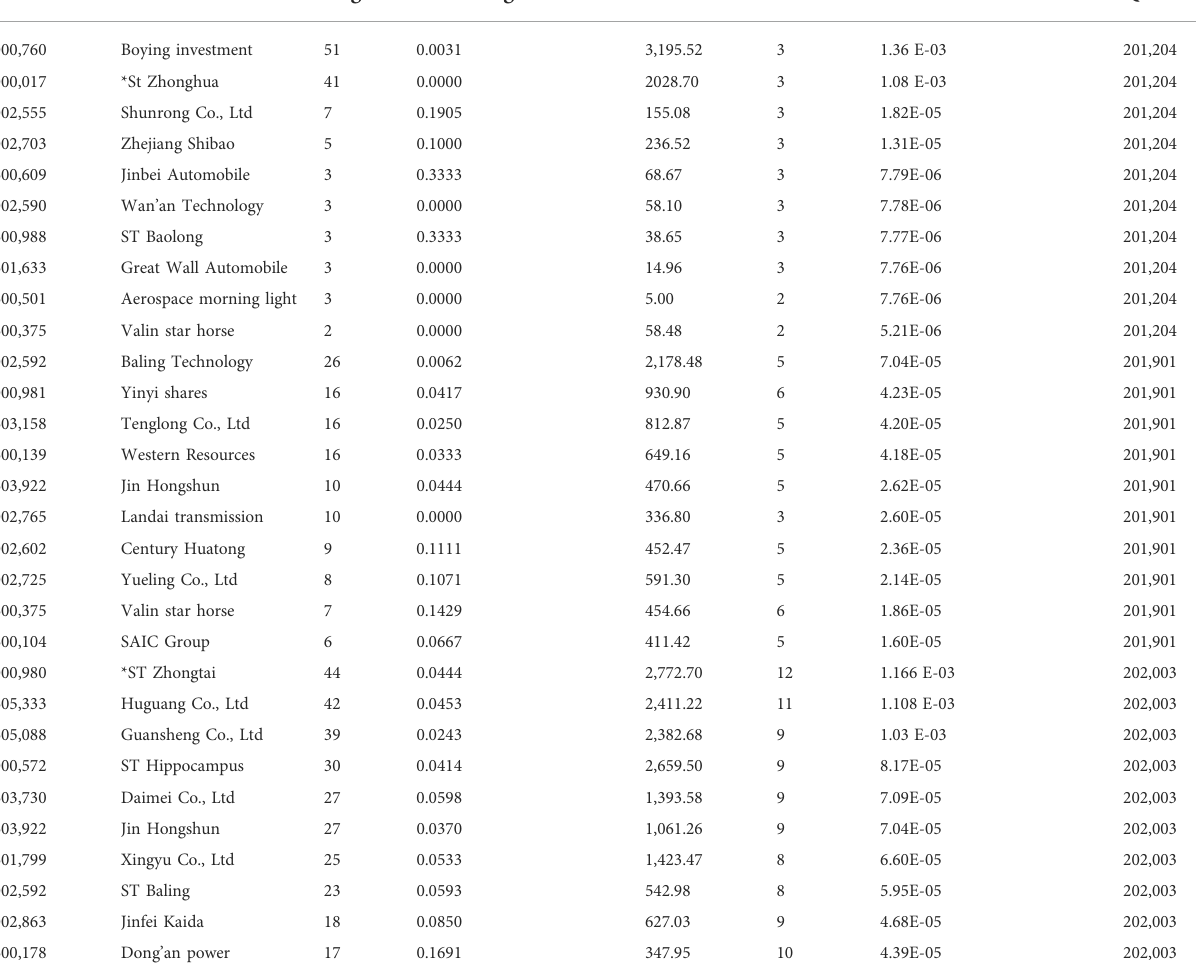
TABLE 8 Multi-index sustainable evaluation index table of China ’ s auto fi nance market network from 2012 to